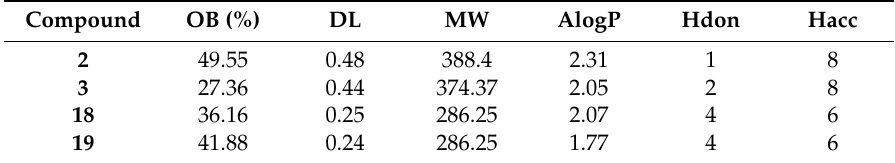
Table 2. DL and OB evaluation of flavonoid compounds with profound protective effects